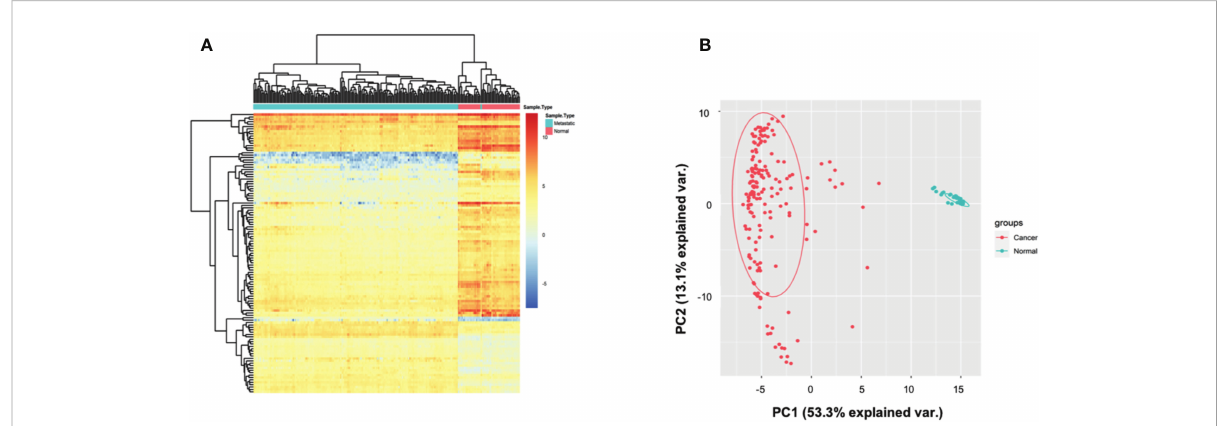
FIGURE 1 Autophagy-associated genes distinguished AML patients from controls. (A) Heatmap showing that the hieratical clustering of autophagy- associated genes separated AML patients from normal controls. (B) Scatterplot showing the gene expressions of autophagy-associated genes in AML patients are different from normal controls by PCA